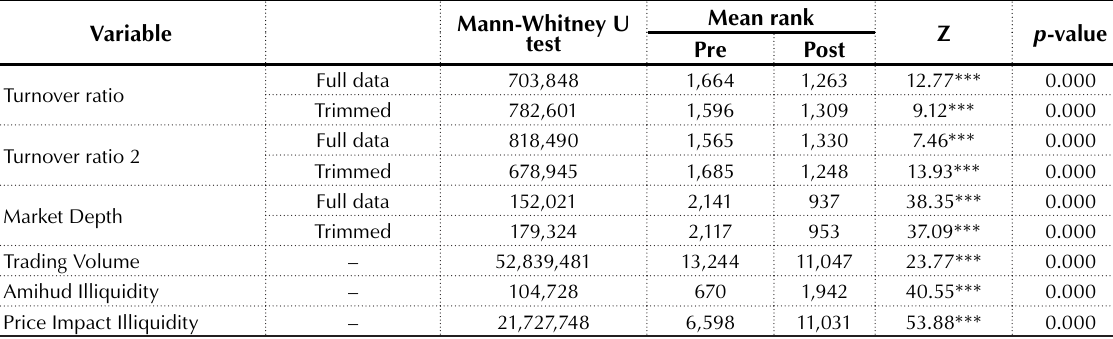
Table 4. Mann-Whitney U test of the five liquidity measures and three trimmed measures Variable